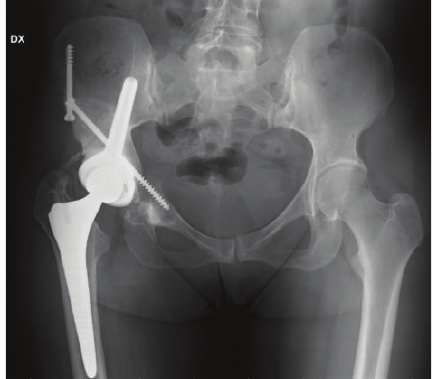
Figure 6: Kaplan-Meier patient survival curve.